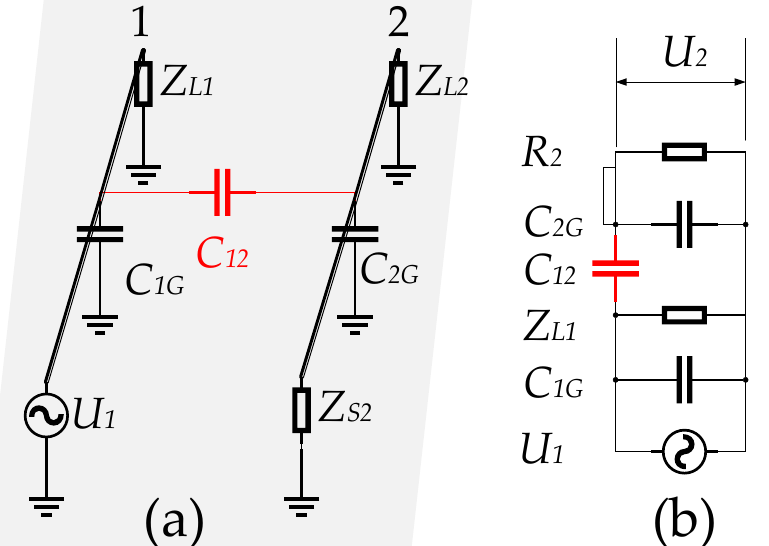
Figure 4. Model of capacitive coupling between two parallel conductors on the ground plane. ( a ) Coupled model; ( b ) Equivalent circuit. According to the equivalent circuit in Figure 4b, the interference voltage on circuit 2 can be expressed as: